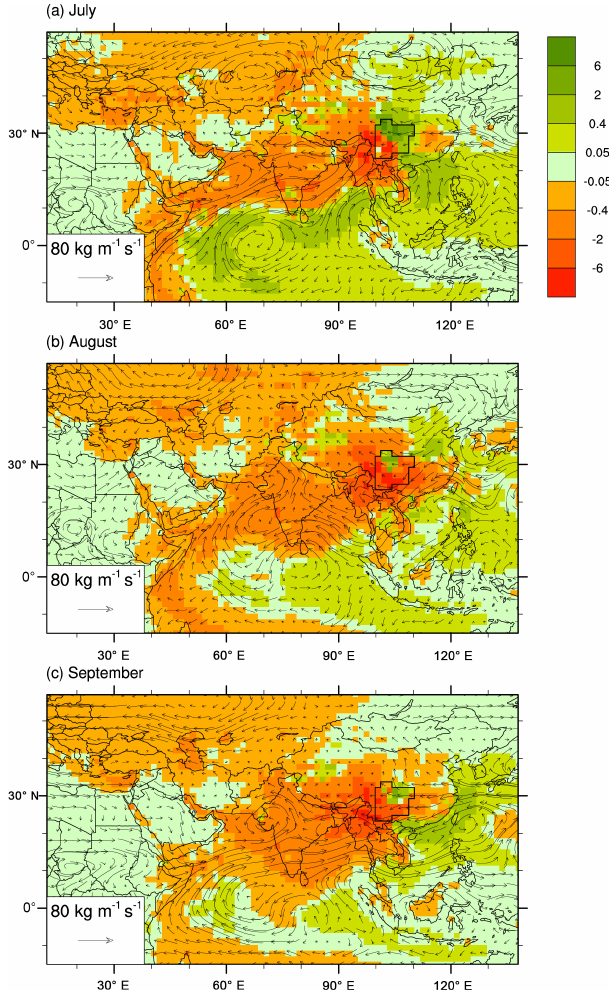
Figure 4. The difference of mean moisture contribution (unit: mmmonth − 1 ; shading) in July (a) , August (b) , and September (c) between 2004–2013 and 1979–1988. The vectors represent the dif- ference of moisture transport.